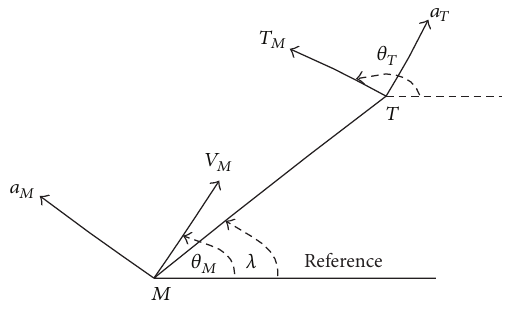
Figure 1: Missile and target geometry.